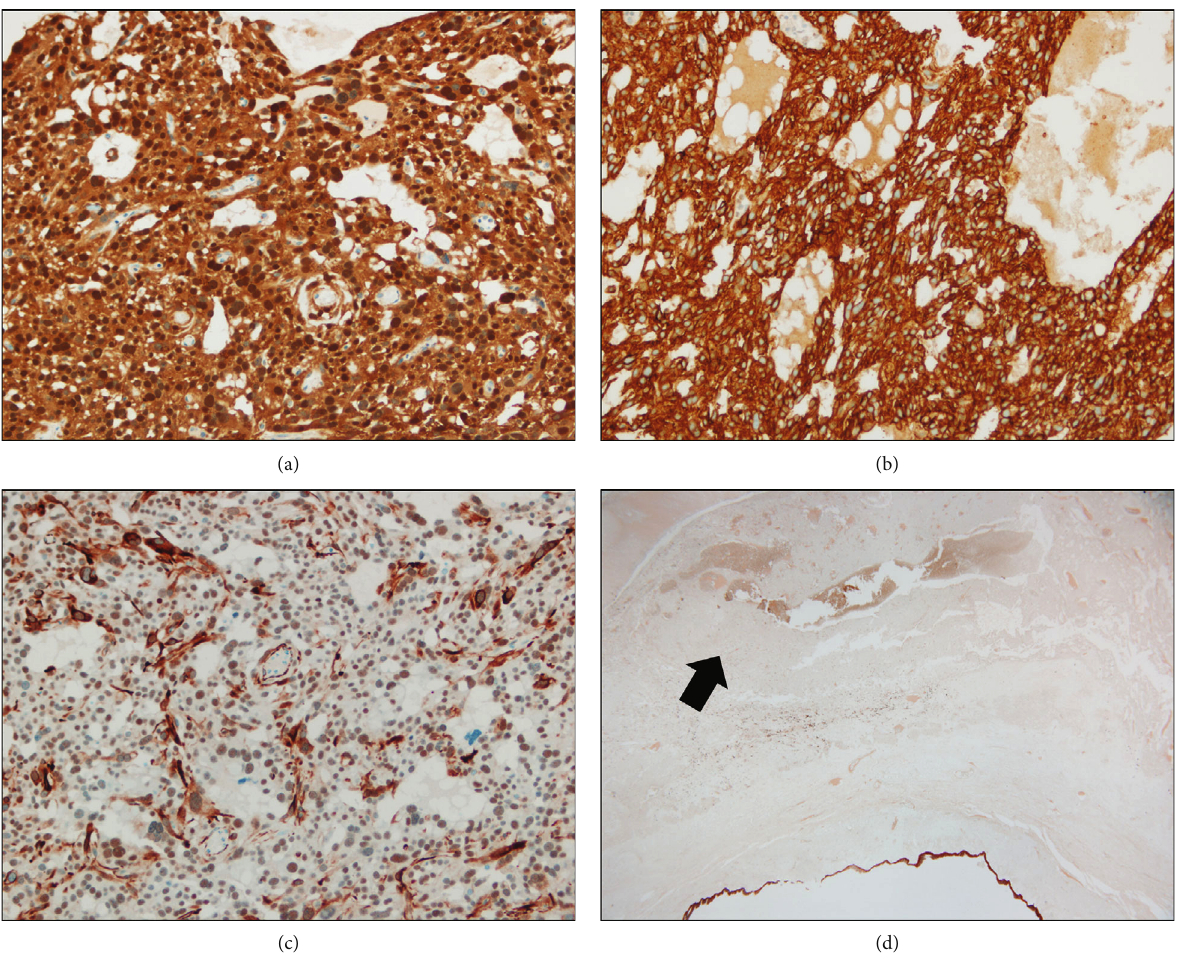
Figure 3: Immunohistochemical stains of MST. (a) Di ff use, strong nuclear and cytoplasmic expression of beta-catenin (20 × ). (b) Di ff use, strong cytoplasmic positivity for CD10 (20 × ). (c) Patchy positivity for WT-1 (20 × ). (d) EMA negativity in MST (arrow). Note the positive staining in mucinous cystadenoma (lower) (1.25 ×